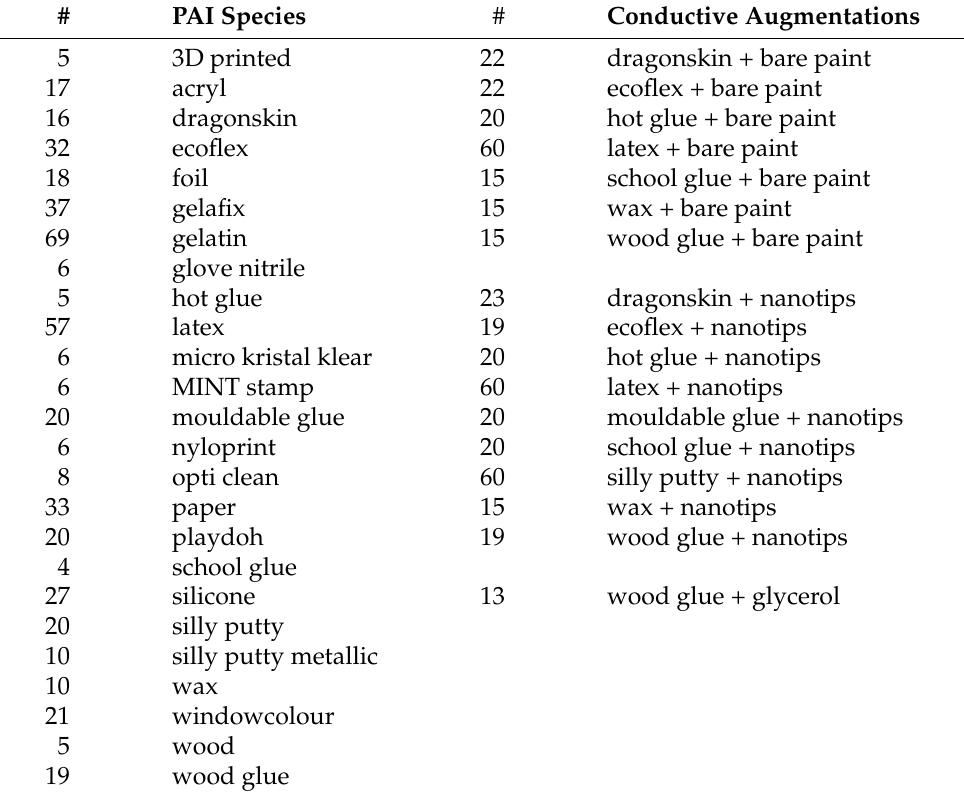
Table 3. A detailed list with the number of samples per PAI